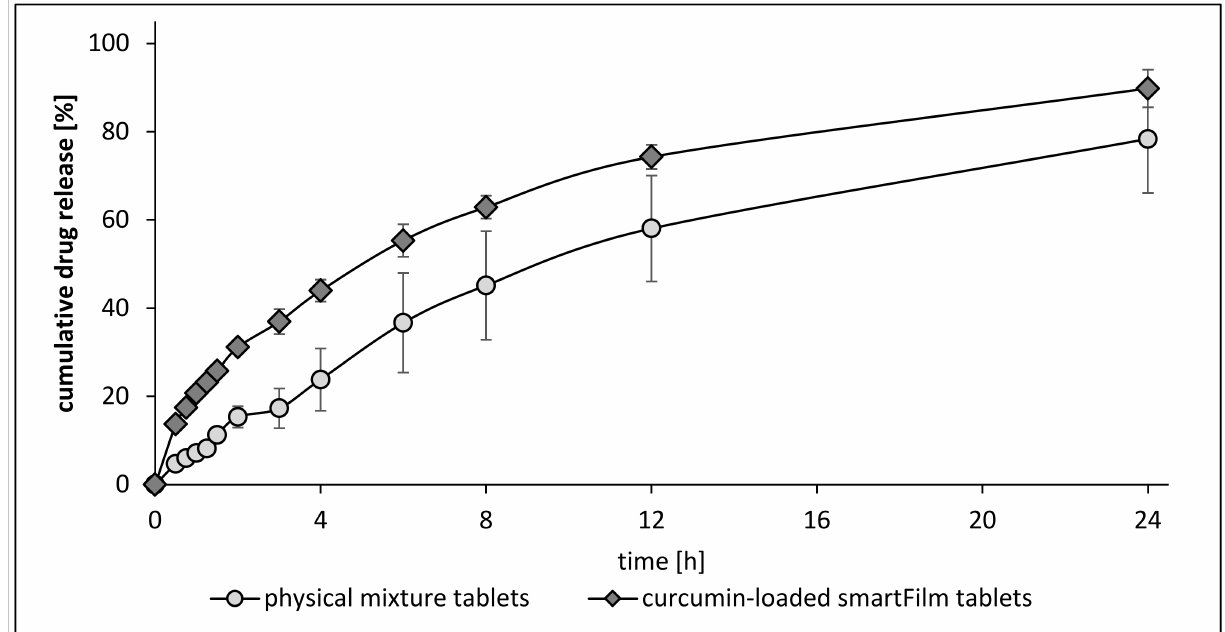
Figure 5. The dissolution profiles of curcumin from physical mixture tablets and curcumin-loaded smartFilm tablets (explanations and details cf. text and Figure